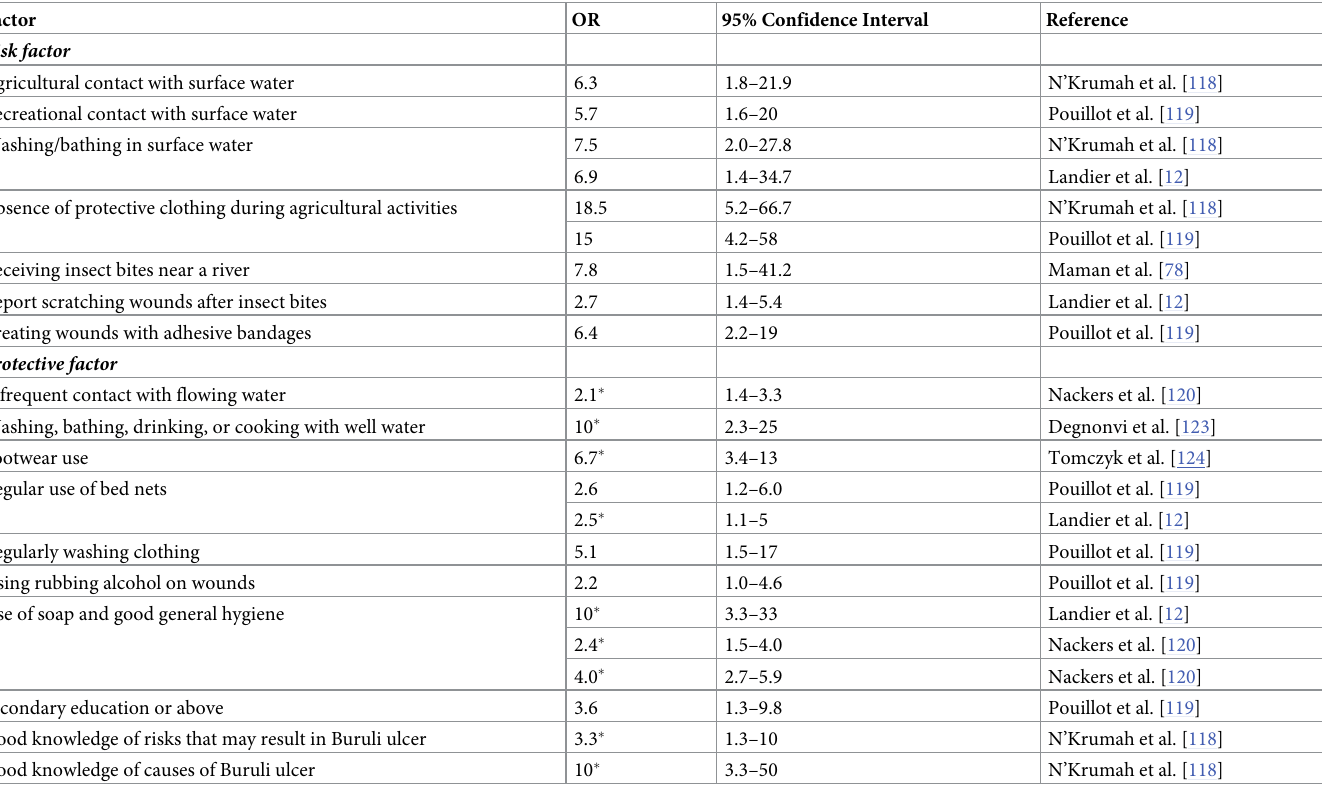
Table 2. Summary of activities and behaviours that influence odds of developing Buruli ulcer infection. Data were taken from case–control studies conducted in regions of Africa endemic for Buruli ulcer. OR refers to the odds of developing Buruli ulcer in cases compared to noninfected controls for “risk factors” and the odds of not developing Buruli ulcer in noninfected individuals compared to infected cases for “protective